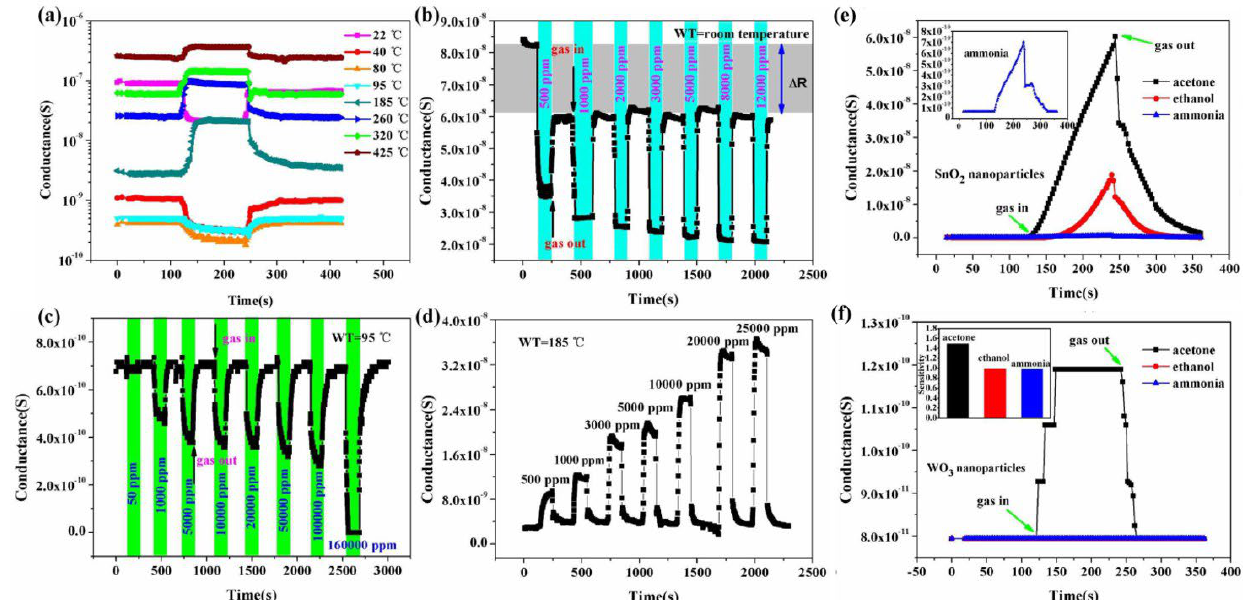
Figure 26. ( a ) Responses of WO 3 − SnO 2 hollow − sphere − based gas sensors towards 5000 ppm ethanol at various temperatures; ( b − d ) the typical sensor response curves to various concentrations of ethanol at room temperature, 95 and 185 °C respectively; ( e , f ) the sensing response of SnO 2 nanoparticles and WO 3 nanoparticles at 95 °C. (Reprinted with permission from [75]. Copyright 2015, American Chemical Society, Washington, DC, USA).